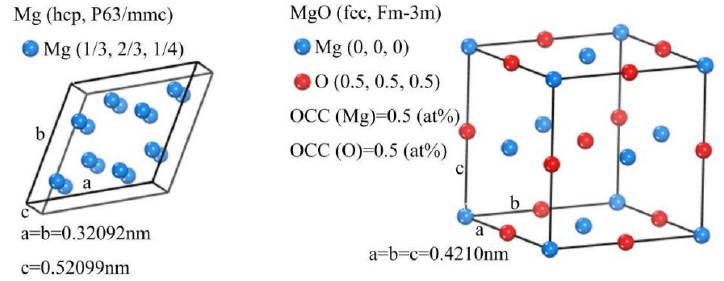
Figure 8. Crystal structure simulations of Mg and MgO.